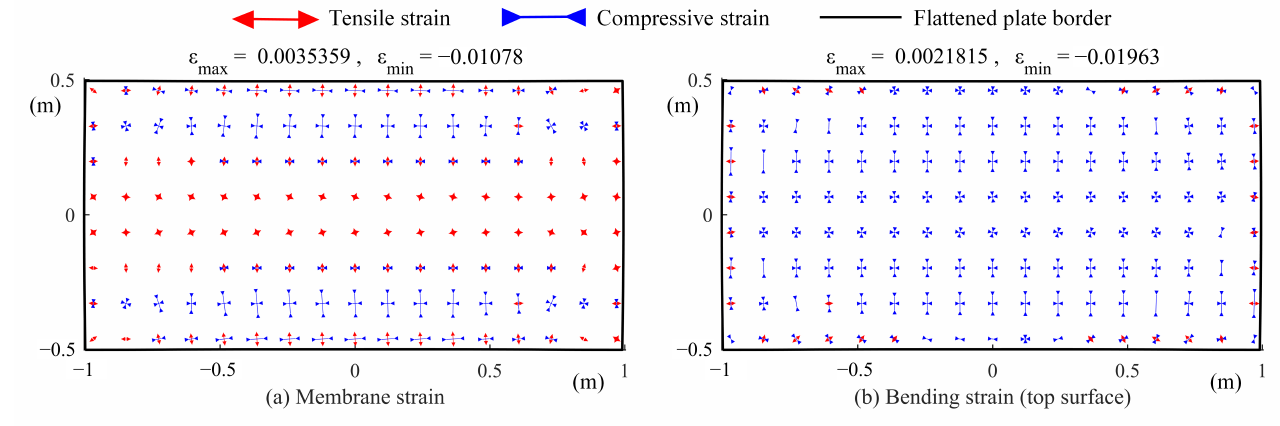
Figure 21. Principal strain vector produced in forming process ( a ) membrane strain, ( b ) bending strain (top